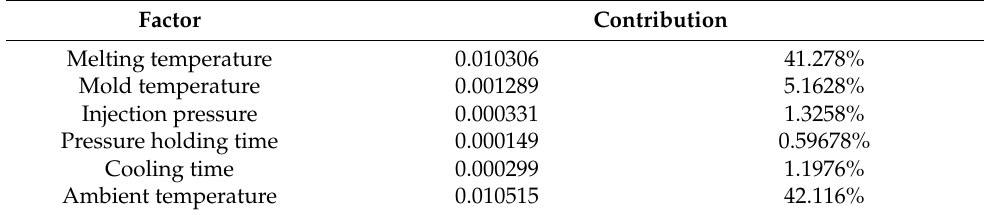
Table 7. Percent contribution of each process